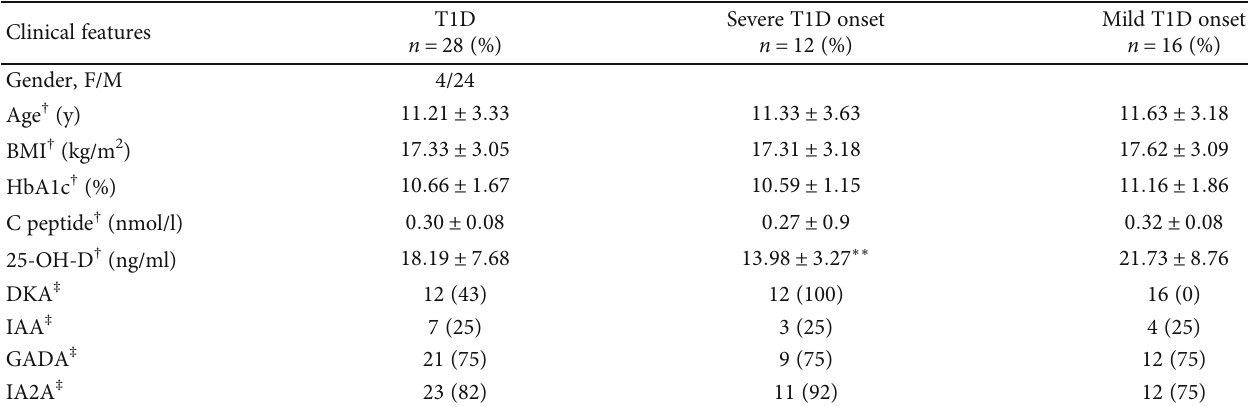
Table 1: Clinical characteristics of type 1 diabetes